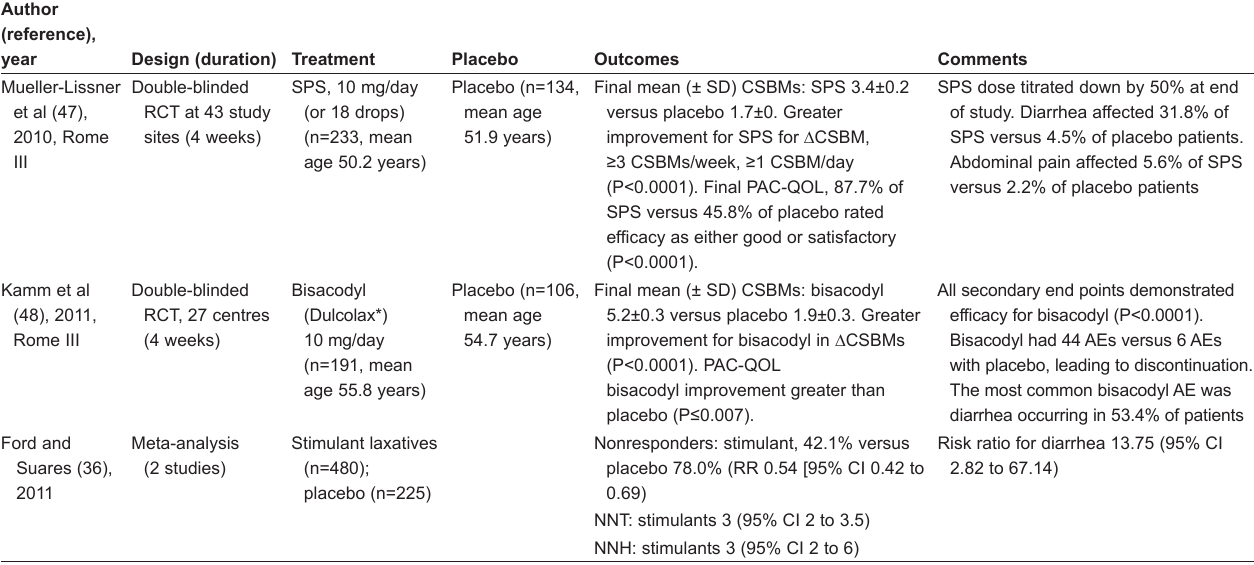
Table 3 Summary of studies assessing the efficacy of stimulant laxatives compared with